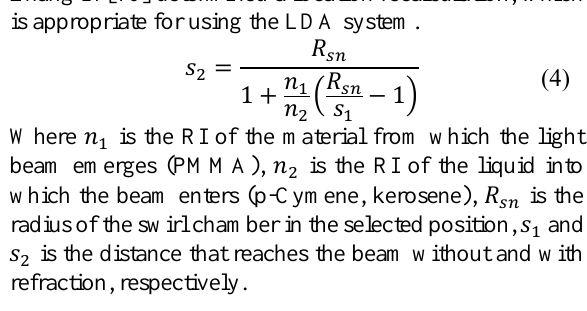
Table 2. Transparent materials obtained by extensive research